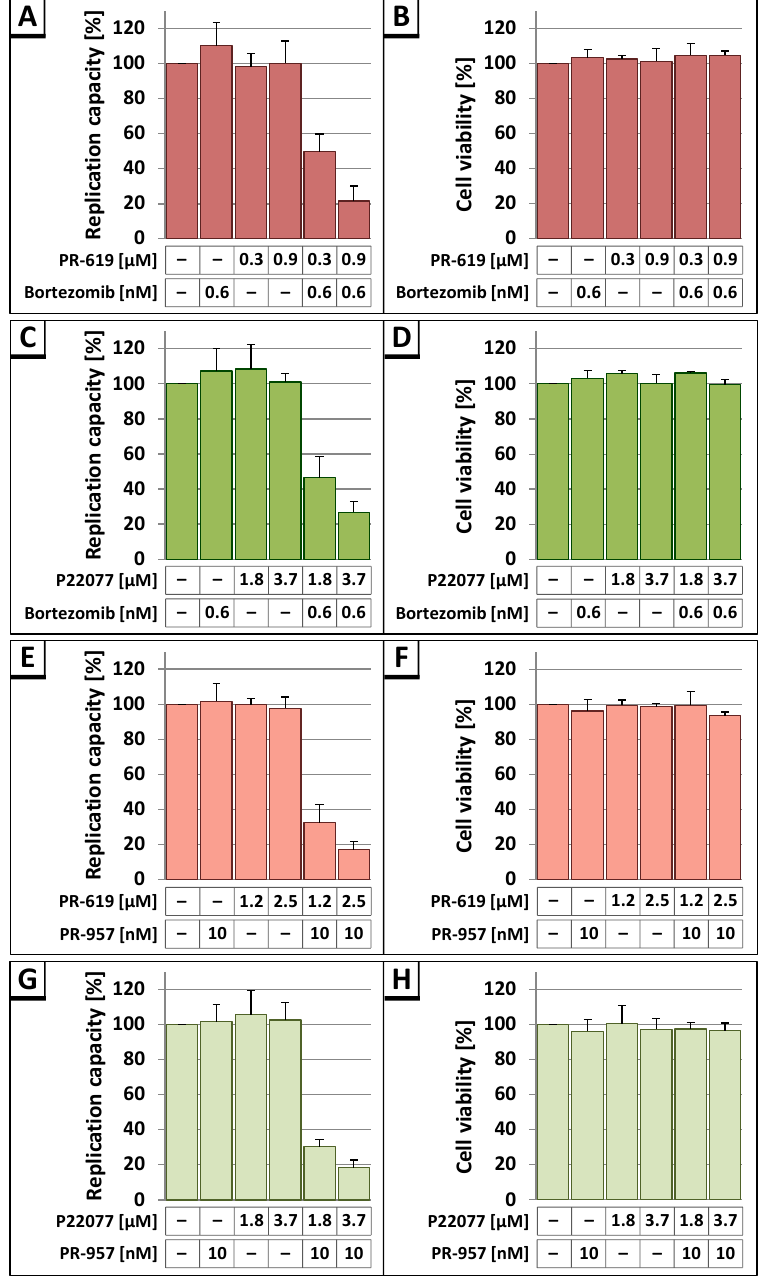
Figure 7. ( A , C , E , G ) Combinatory treatment of HLAC with DIs PR-619 or P22077 together with proteasome inhibitors Bortezomib or PR-957 leads to a reduced replication capacity of HIV-1. Following infection of HLAC with HIV-1 NL4-3 (1 ng p24), permanent treatment with indicated amounts of PR-619 or P22077 alone, or together with 0.6 nM Bortezomib or 10 nM PR-957, respectively, was performed. The replication capacity of HIV-1 NL4-3 was assessed by calculating the AUC from each individual replication profile. The replication capacity of untreated HIV-1 NL4-3 in each experiment was set to 100%. Bars represent the mean values of 4 ( A ), 5 ( C ), or 3 ( E , G ) independent experiments ± SD; ( B , D , F , H ) Cell viability was assessed by WST-1 assay. HLAC were infected with HIV-1 NL4-3 (1 ng p24), followed by permanent treatment with indicated amounts of PR-619 or P22077 alone, or together with 0.6 nM Bortezomib or 10 nM PR-957, respectively. Untreated, HIV-1 NL4-3 infected cells were set to 100%; Bars represent the mean values of 4 ( B , D ) or 3 ( F , H ) independent experiments ± SD.